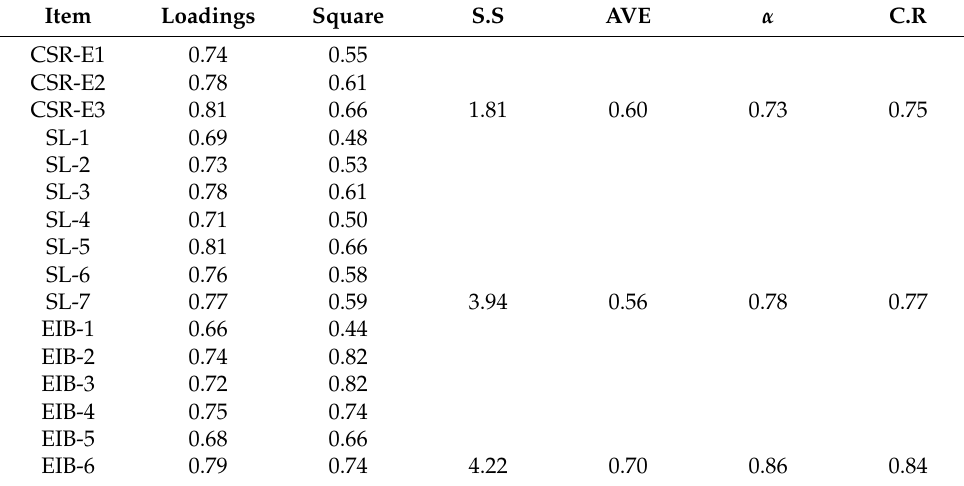
Table 2. Item loadings, convergent validity, and reliability